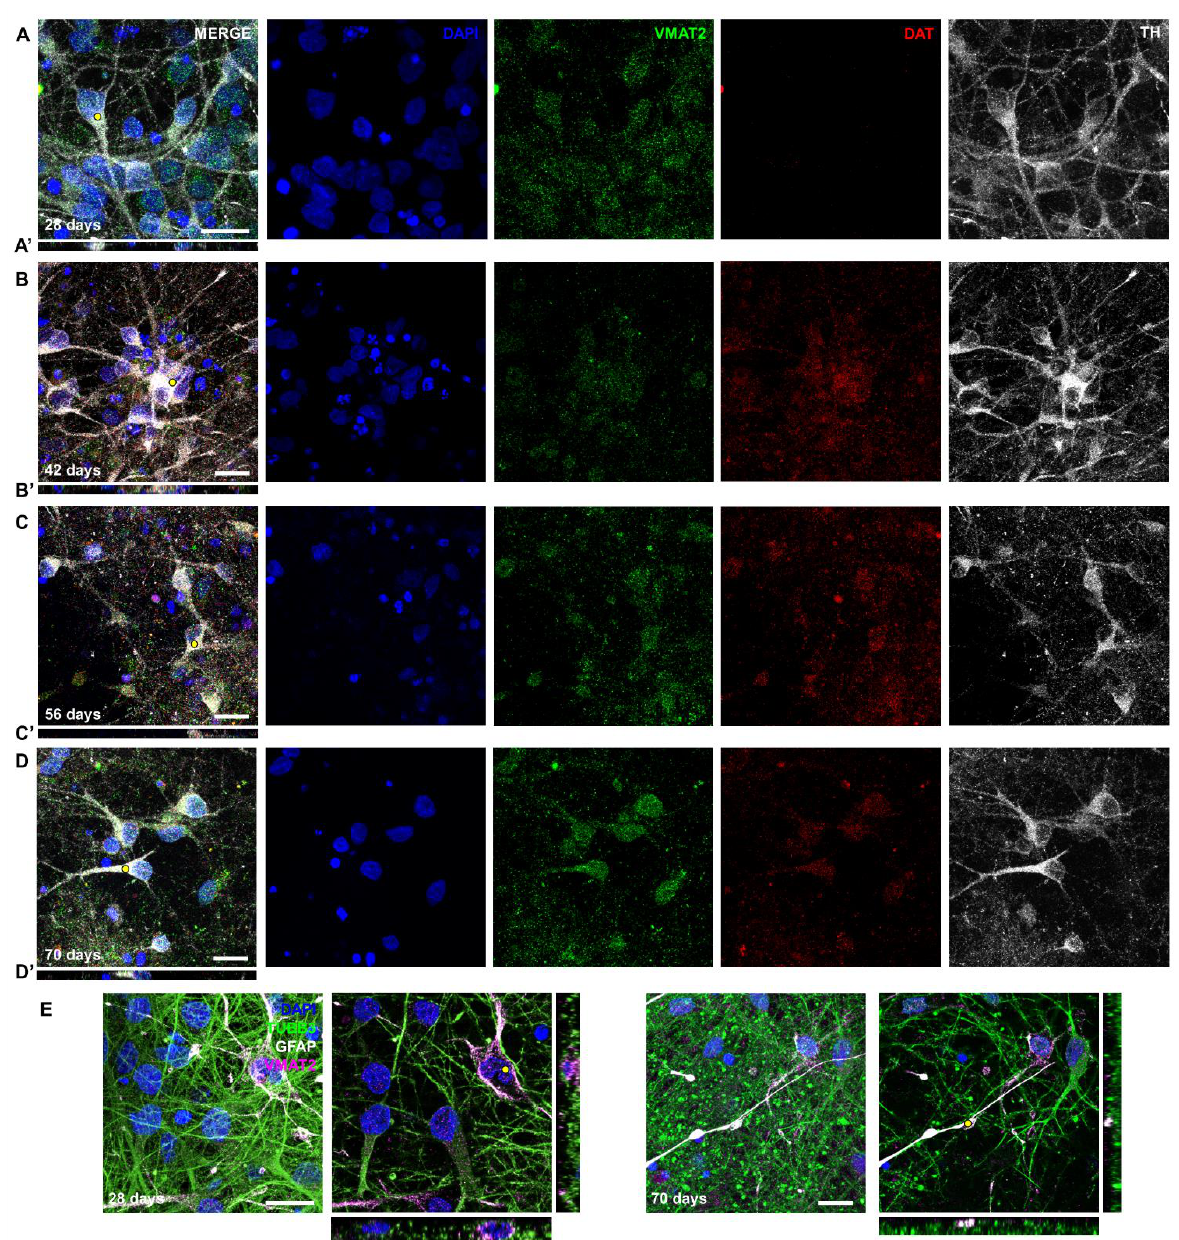
Figure 3. Differentiating NPCs express specific markers for dopaminergic neurons. ( A – D ) Maximum projections (5 μm) of the same time points as in Figure 1 showing neurons that express TH and transporter proteins VMAT2 and DAT. ( A’ – D’ ) XZ projection of ( A – D ). Yellow dot in corresponding image indicates where slice was made. ( E ) Maximum projections (10 μm) and single images showing intense staining of VMAT2 in GFAP + astrocytes. Scale bar: 20 μm.